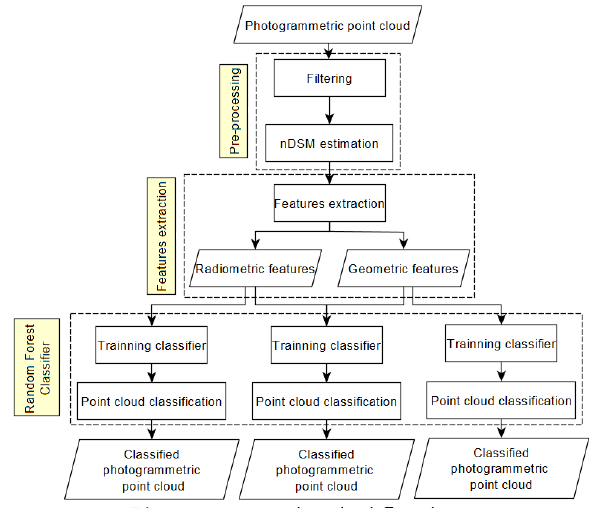
Figure 1. Proposed method